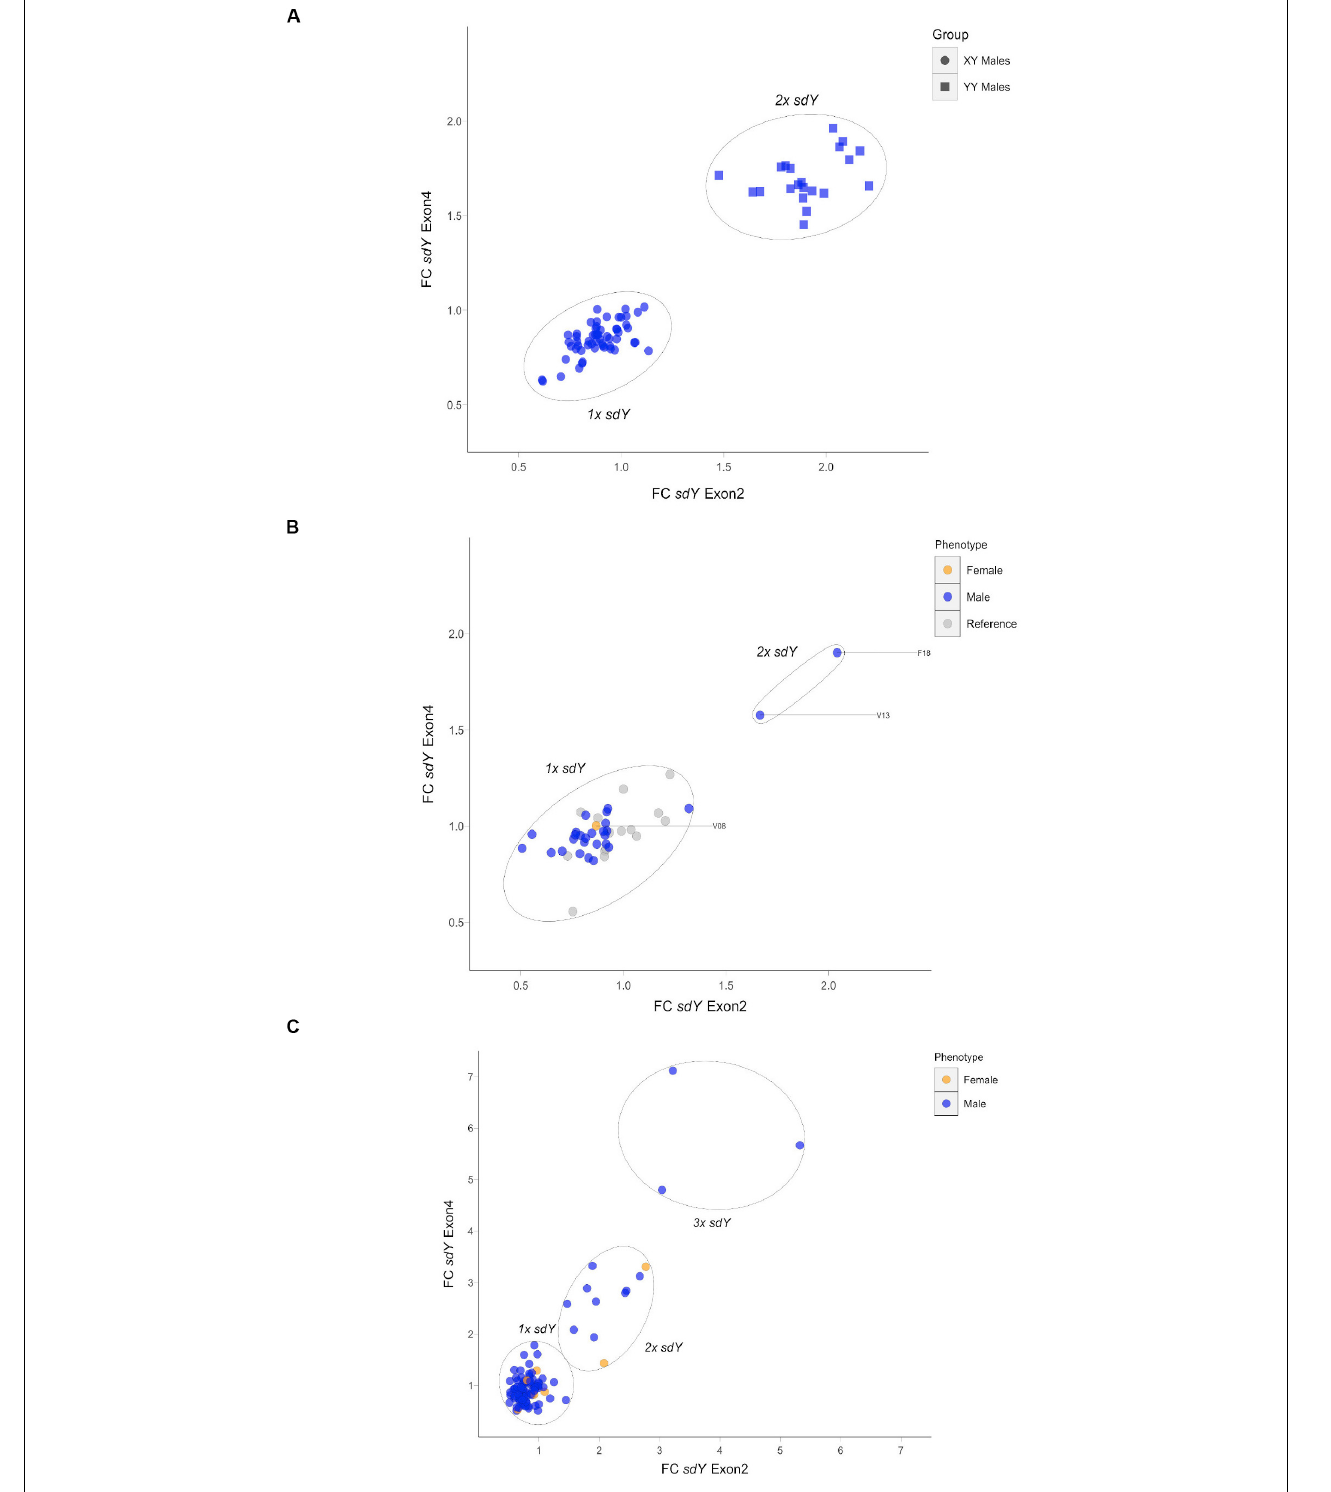
FIGURE 2 | Real time PCR based fold change (FC) values for sdY exon2 and exon4 amplicons. (A) Validation RT PCR using XY males and YY super-males; round and square dots, respectively. (B) Parental individuals for the F1-K2012 families showing 1–2 × sdY sires individuals, in blue, and the 1 × sdY discordant dam in orange. Reference 1 × sdY males are displayed in gray. (C) Example plate showing 1–3 × sdY males and 1–2 × sdY females in blue and orange, respectively, among the offspring. Reference males not displayed.